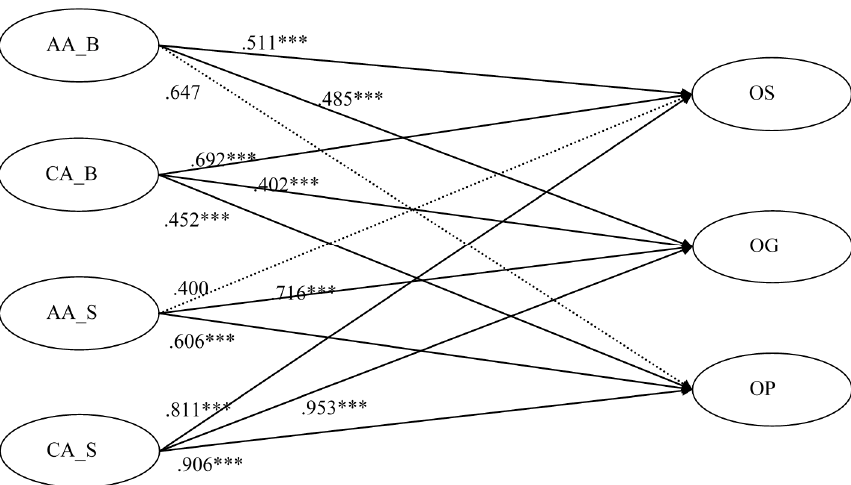
Figure 4. Research model with standardized path coefficients (Part 2). Note. * p < 0.05, ** p < 0.01,